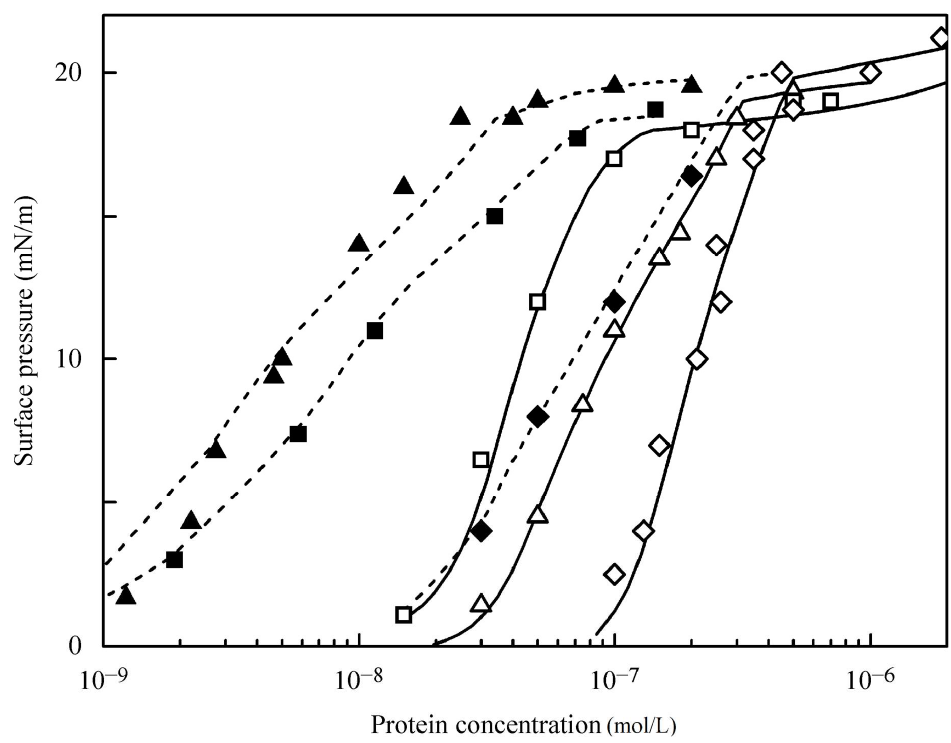
Figure 4. Experimental surface pressure isotherms for the solutions of HSA ( (cid:3) ), BCS ( (cid:52) ), and BLG ( obtained by the drop profile method with respect to the initial concentration c 0 . The solid lines are the isotherms calculated with respect to c 0 by using the parameters from the Table 1. (cid:4) and (cid:78) are data from [35] for HSA and BCS solutions, respectively, obtained by the bubble profile method; (cid:4) are the data for BLG solutions obtained in the present study by the bubble profile method. The dashed lines are the isotherms calculated with respect to the equilibrium concentration